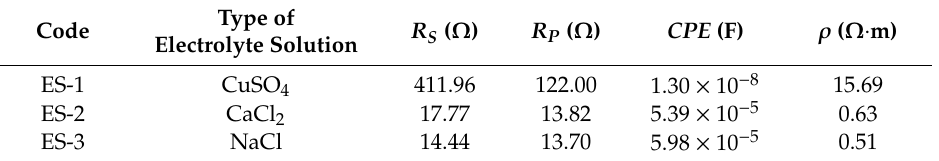
Table 10. Parameters of equivalent circuit and resistivity of the specimens with di ff erent solute.